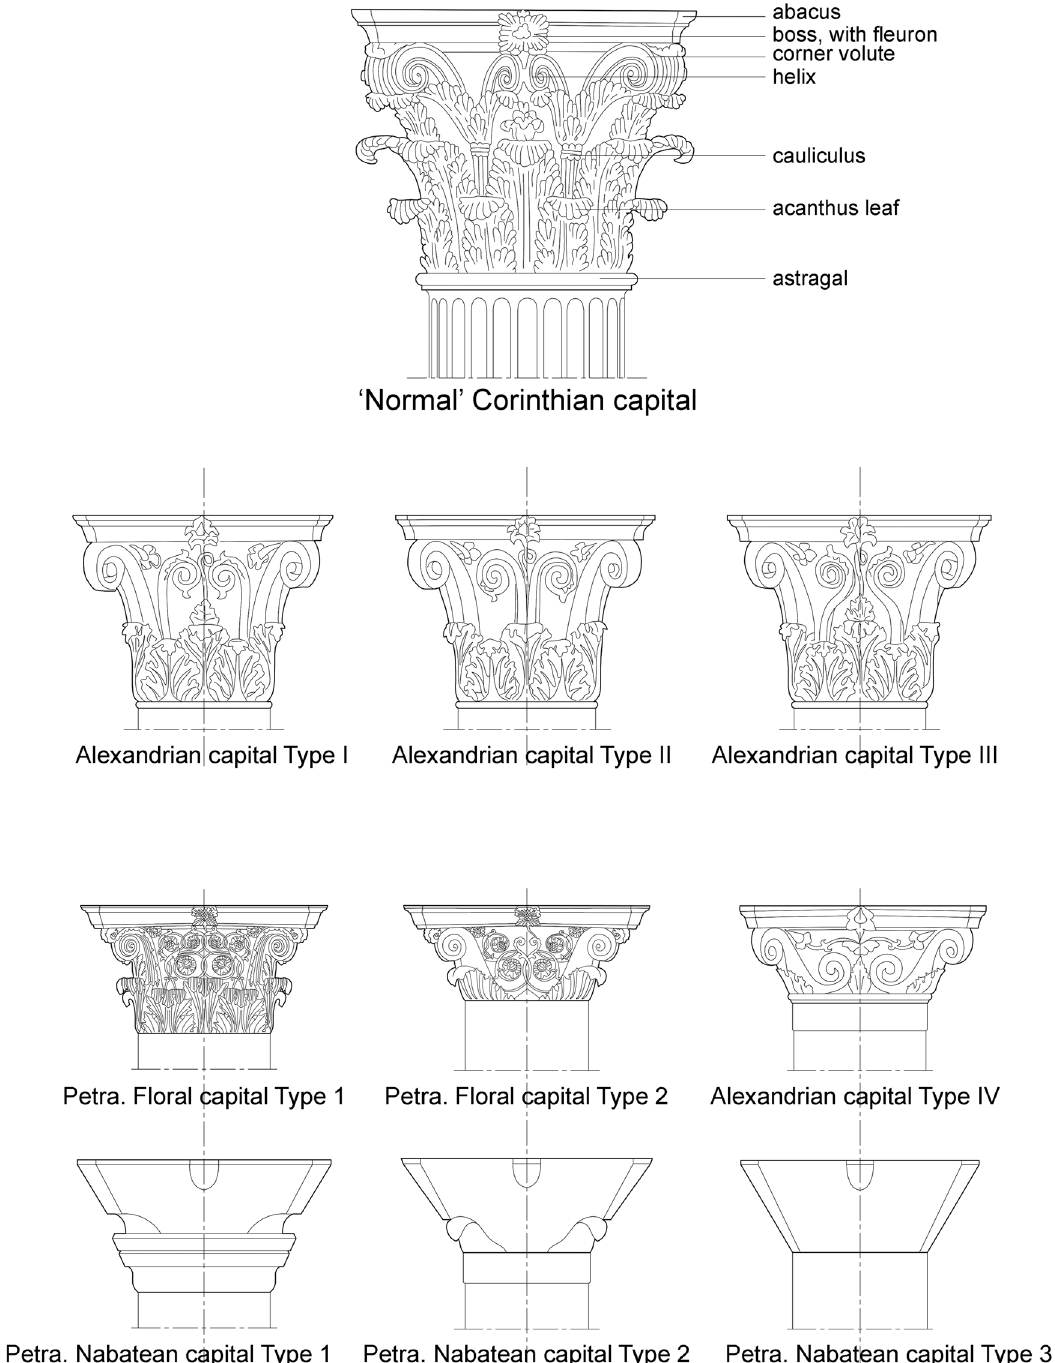
Figure 8: Evolution of capitals forms. “ Normal ” Corinthian, Alexandrian, Floral, and Nabatean Types ( drawing: U. Kra ś niewska, based on McKenzie, 1990, p. 190; 2007, p. 85 )